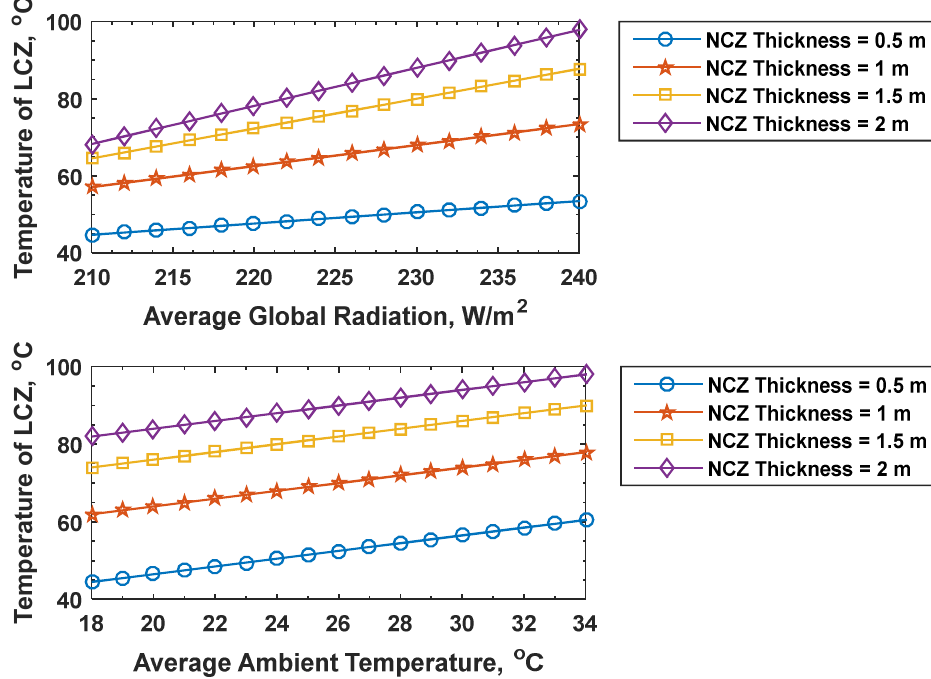
Figure 7. Effect of average global radiation and average ambient temperature on the LCZ tempera- ture.